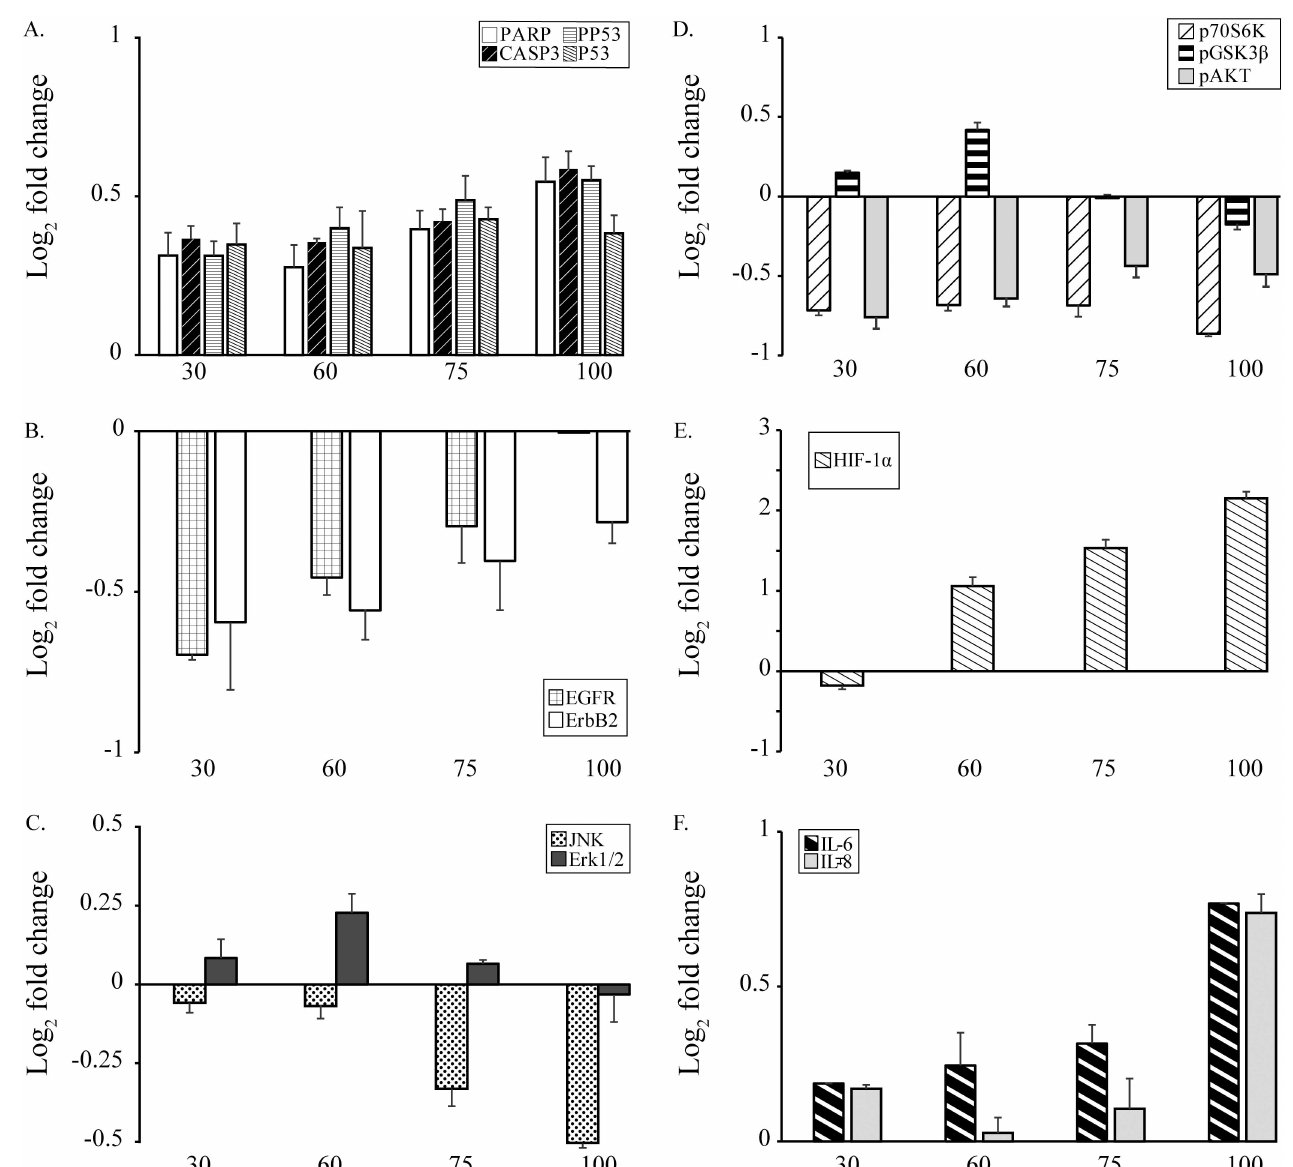
Fig 1. Changesin proteinexpressionof the 14 pathwayregulatorsinducedby Ni (II). Panel A: Apoptosispanel proteinscleaved PARP, cleaved caspase-3, p53, pp53; Panel B: Two cell growth panel proteins EGFR and ErbB2; Panel C: MAP Kinase panel proteinsJNK and Erk1/2; Panel D: phosphorylatedp70S6K, GSK3 β ,and Akt; Panel E: HIF-1 α ;Panel F: IL-6 and IL-8.X-axis is Ni (II)concentrations ( μ M).Y-axis: log 2 relative-fold changeof expression and/orphosphorylation levels comparedto untreatedcontrols measuredusing multiplexed ELISA. Protein significantly alteredover the corresponding controlswere identifiedand plottedas up-regulated(above the X-axis)or down-regulated (blow the X- axis).Statisticaldifferences in proteinexpression or phosphorylation between Ni (II) treatedand controlgroup were determinedby Student’s t-test (n = 3, p <